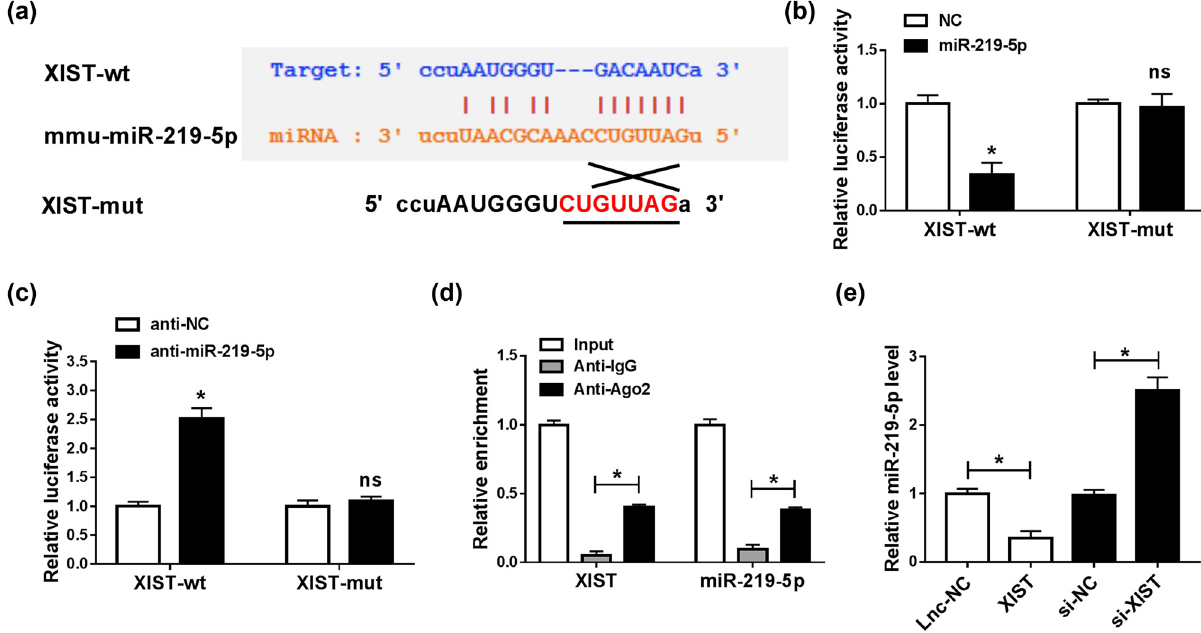
Figure 4: XIST sponged miR - 219 - 5p to suppress miR - 219 - 5p expression. ( a ) The potential binding sites between XIST and miR - 219 - 5p were predicted by starBase. ( b and c ) XIST - wt ( or XIST - mut ) and miR - 219 - 5p ( or NC, anti - miR - 219 - 5p, anti - NC ) were co - transfected into BV2